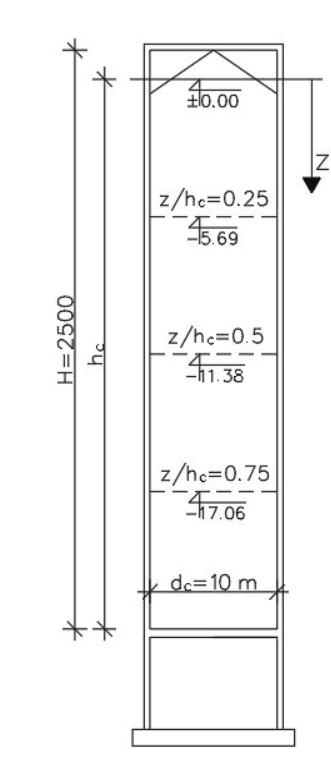
Figure 4: Calculation model of a free-standing silo with height H = 25 m and diameter d element method; and b) levels of reference in the silo adopted for the analysis of internal forces.